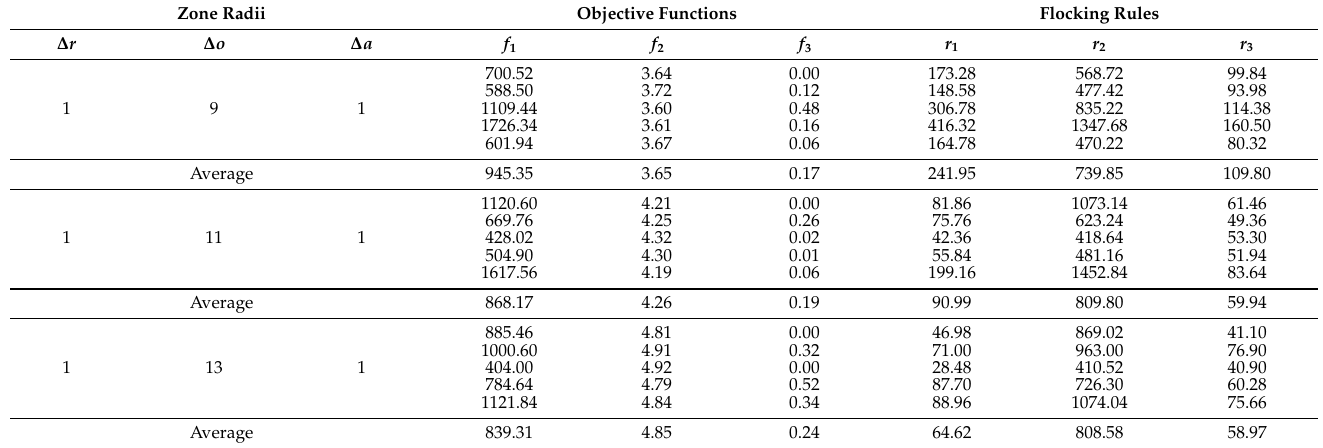
Table A3. Results of testing perception zones for flocks with 50 agents.